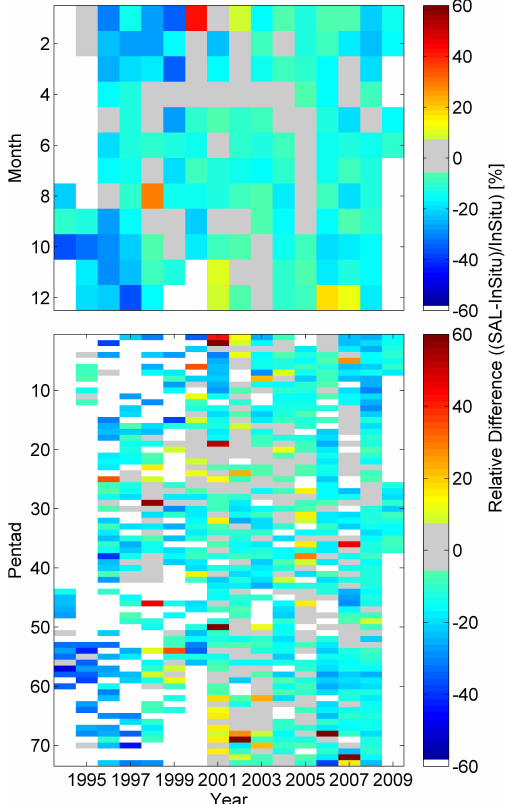
Fig. 3. The relative retrieval error of CLARA-SAL at SGP between 1994–2009. Upper subplot indicates color-coded relative retrievals errors of monthly means; the lower subplot shows the same for pen- tad means. The grey color indicates a retrieval error within ± 5%. Cells with white color indicate non-available satellite or in situ data.